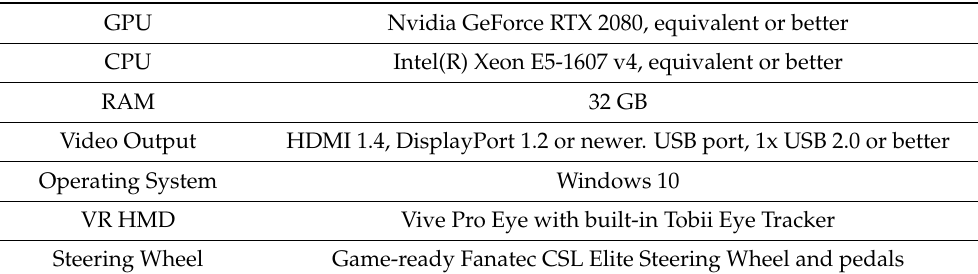
Table 1. An overview of the used components in the LoopAR setup. The steering wheel and the VR device are only suggestions in this listing. The LoopAR toolkit also works with other